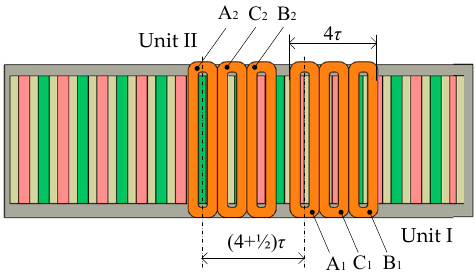
Figure 5. Structure and arrangement of the two sets of windings.